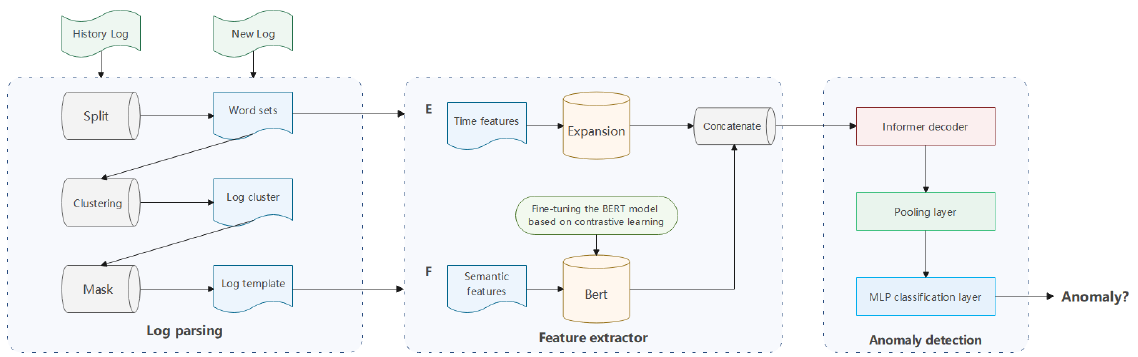
Figure 1. Overview structure of MDFULog. Split, clustering, and mask are used to parse the log, extract its valid information, and capture the semantic and temporal features for vectorization, and an Informer-based classification model is used for anomaly